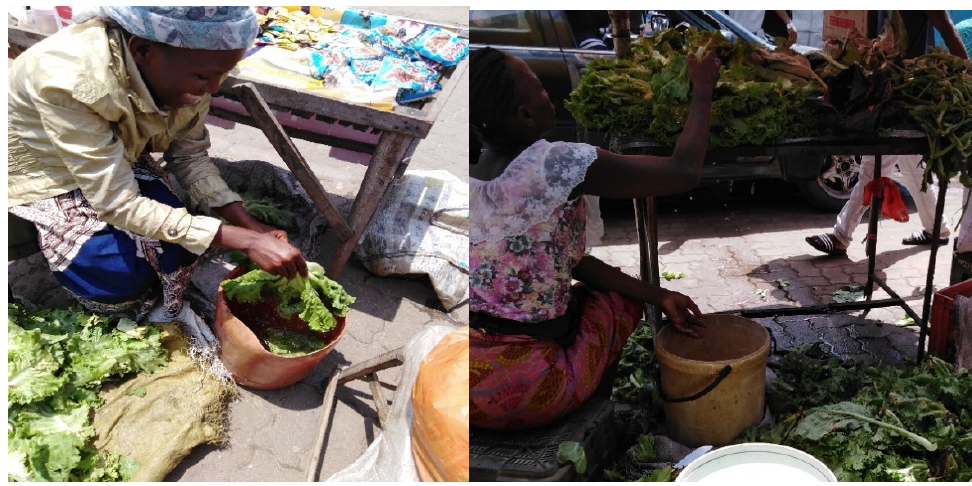
Figure 6. Handling of lettuce and cabbage in a plastic container, on Benfica’s market.